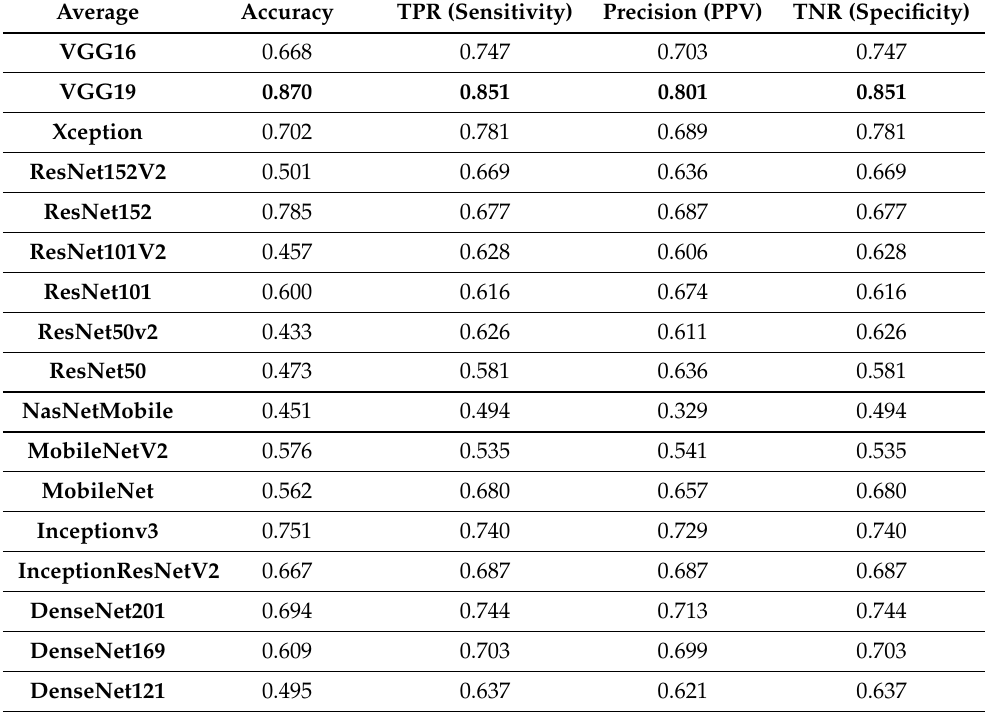
Table 4. Average metric results related to duration = 50 s